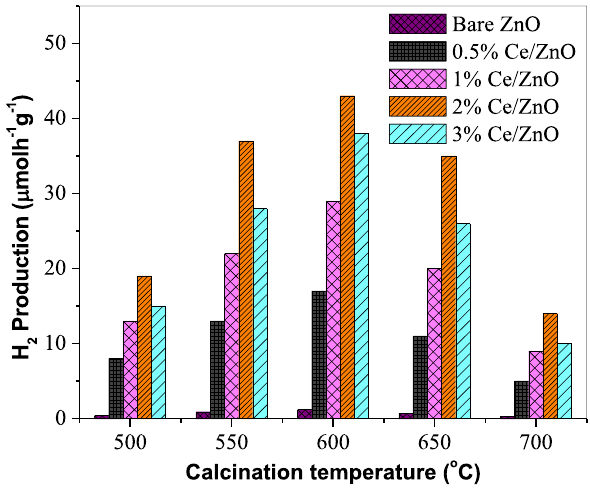
Fig. 2 Effect of calcination temperature of Ce/ZnO on photocatalytic H 2 production by means of decomposition of 10vol% methanol–water